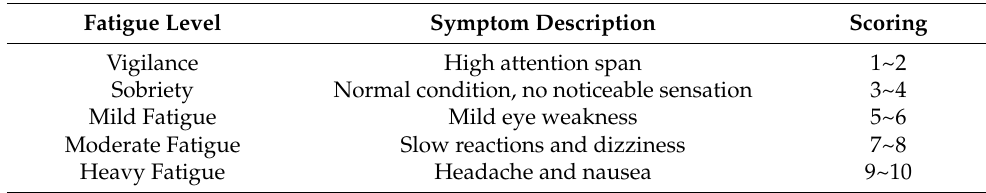
Table 1. Subjective Fatigue Scale.